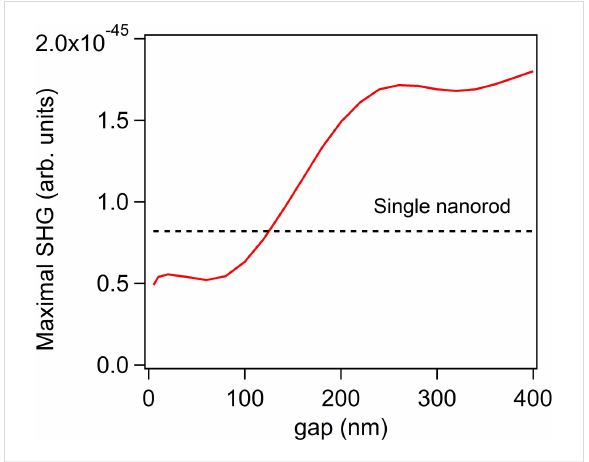
Figure 3: Maximal second harmonic generation (SHG) as a function of the gap between the nanorods. The maximal SHG has been extracted from the second harmonic spectra, see Figure 1c for example. The SH intensity from a single nanorod is shown as a dotted black